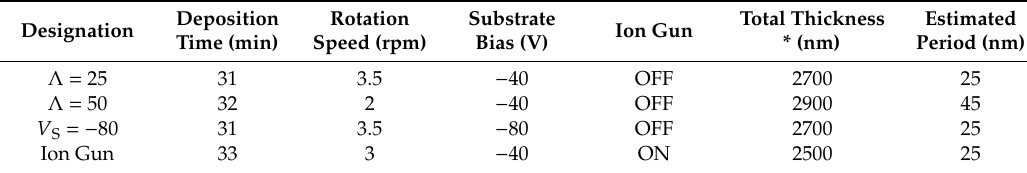
Table 1. Al / Ni (V) multilayer thin films deposited by magnetron